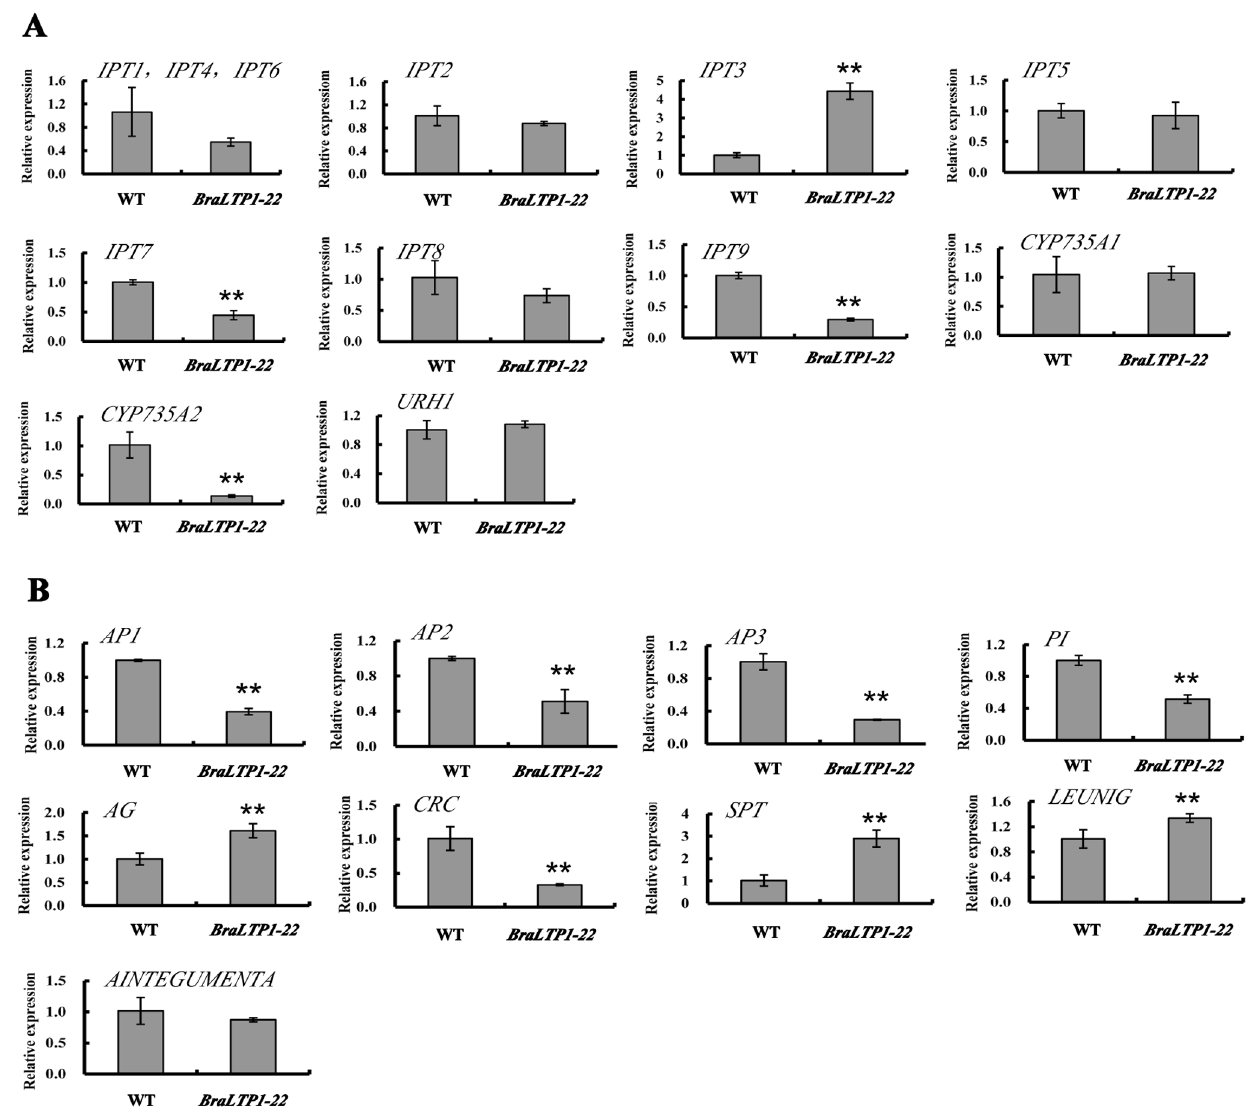
Figure 10. Transcript abundance of various cyctokinin-related (A) and flowering-related (B) genes in 35S::BraLTP1 ( BraLTP1-22 ) and wild type (WT) plants as determined by qRTPCR. Data is the average of three plants with standard errors. Asterixes indicate significant differences to WT (** P , 0.01).